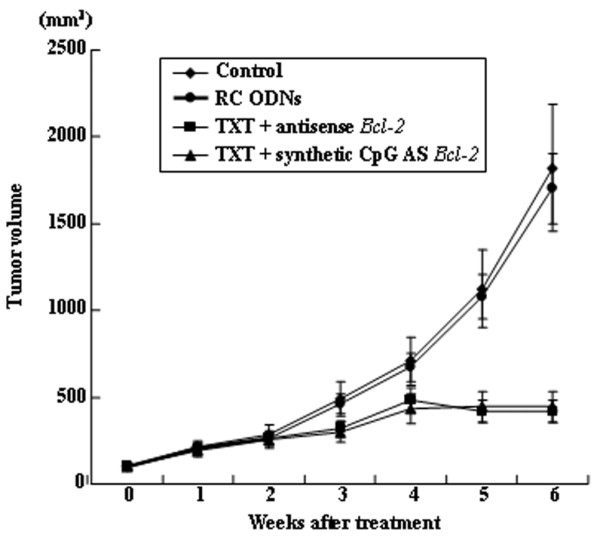
Effect of synthetic CpG antisense Bcl-2 on BT-474 cells in comparison with antisense Bcl-2. Each point represents the mean tumor volume of the four mice in each group. Error bars indicate SD. The data presented are from two independent experiments. RC, random control; TXT, docetaxel.